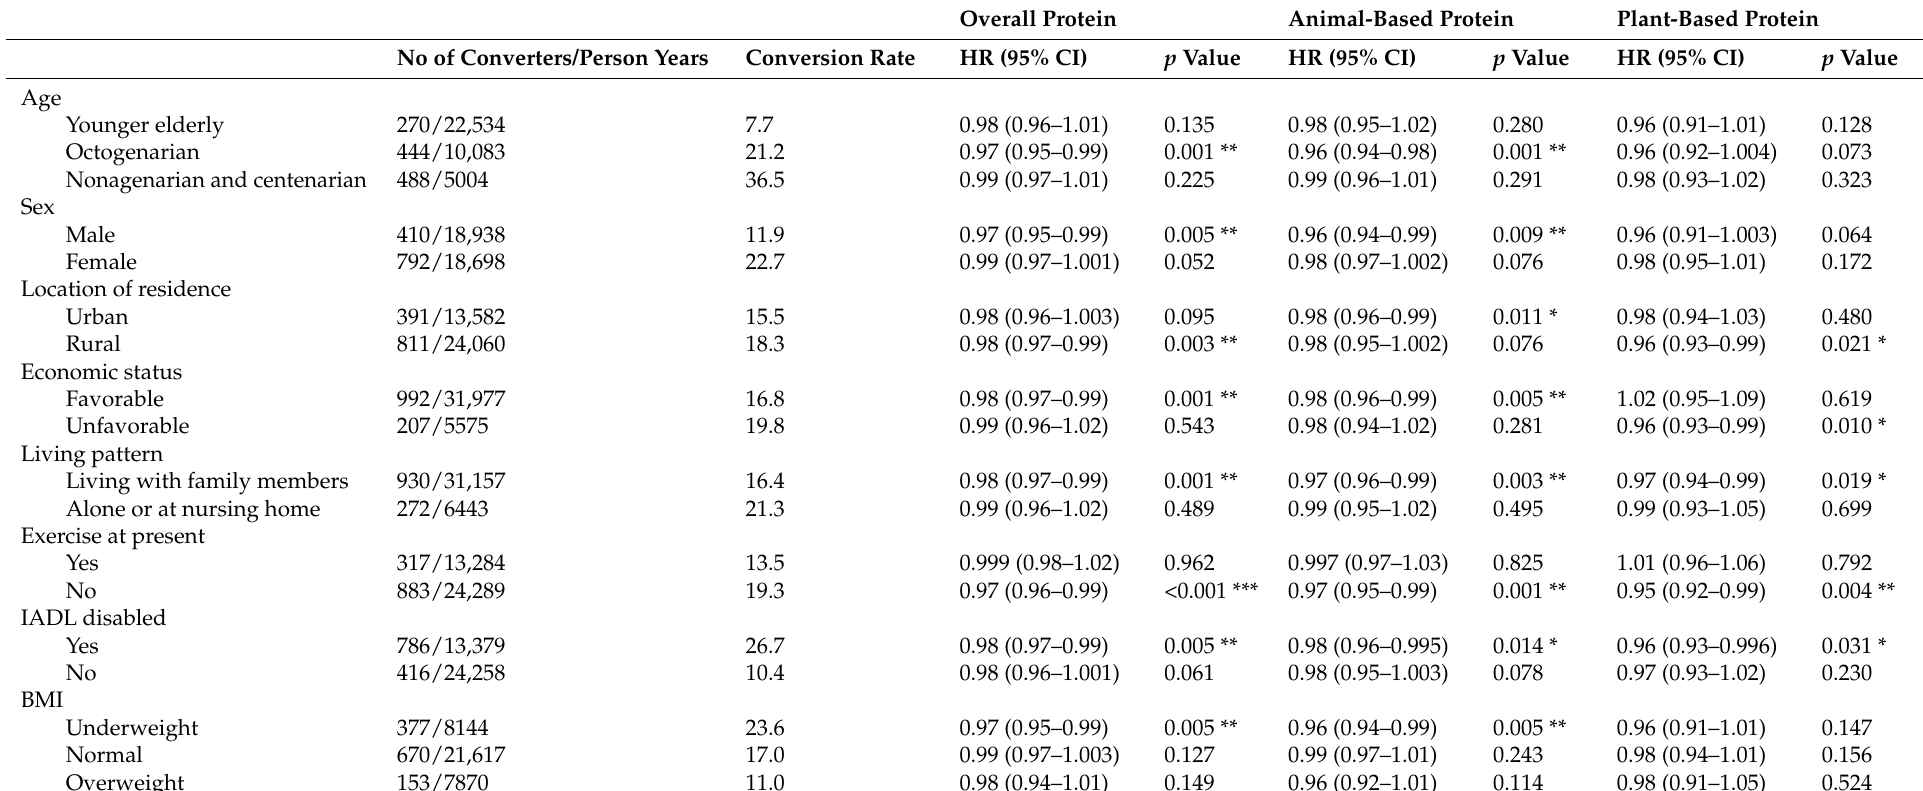
Table 4. The association between change in protein intake and cognitive impairment in subgroups. Overall Protein Animal-Based Protein Plant-Based